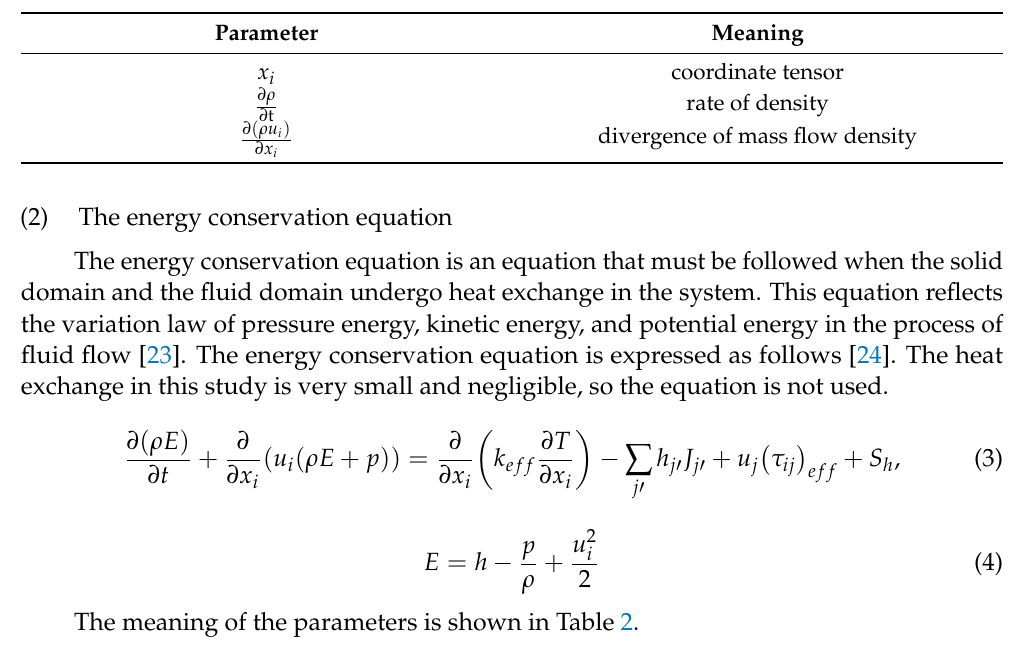
Table 1. Parameter meaning of mass conservation equation.